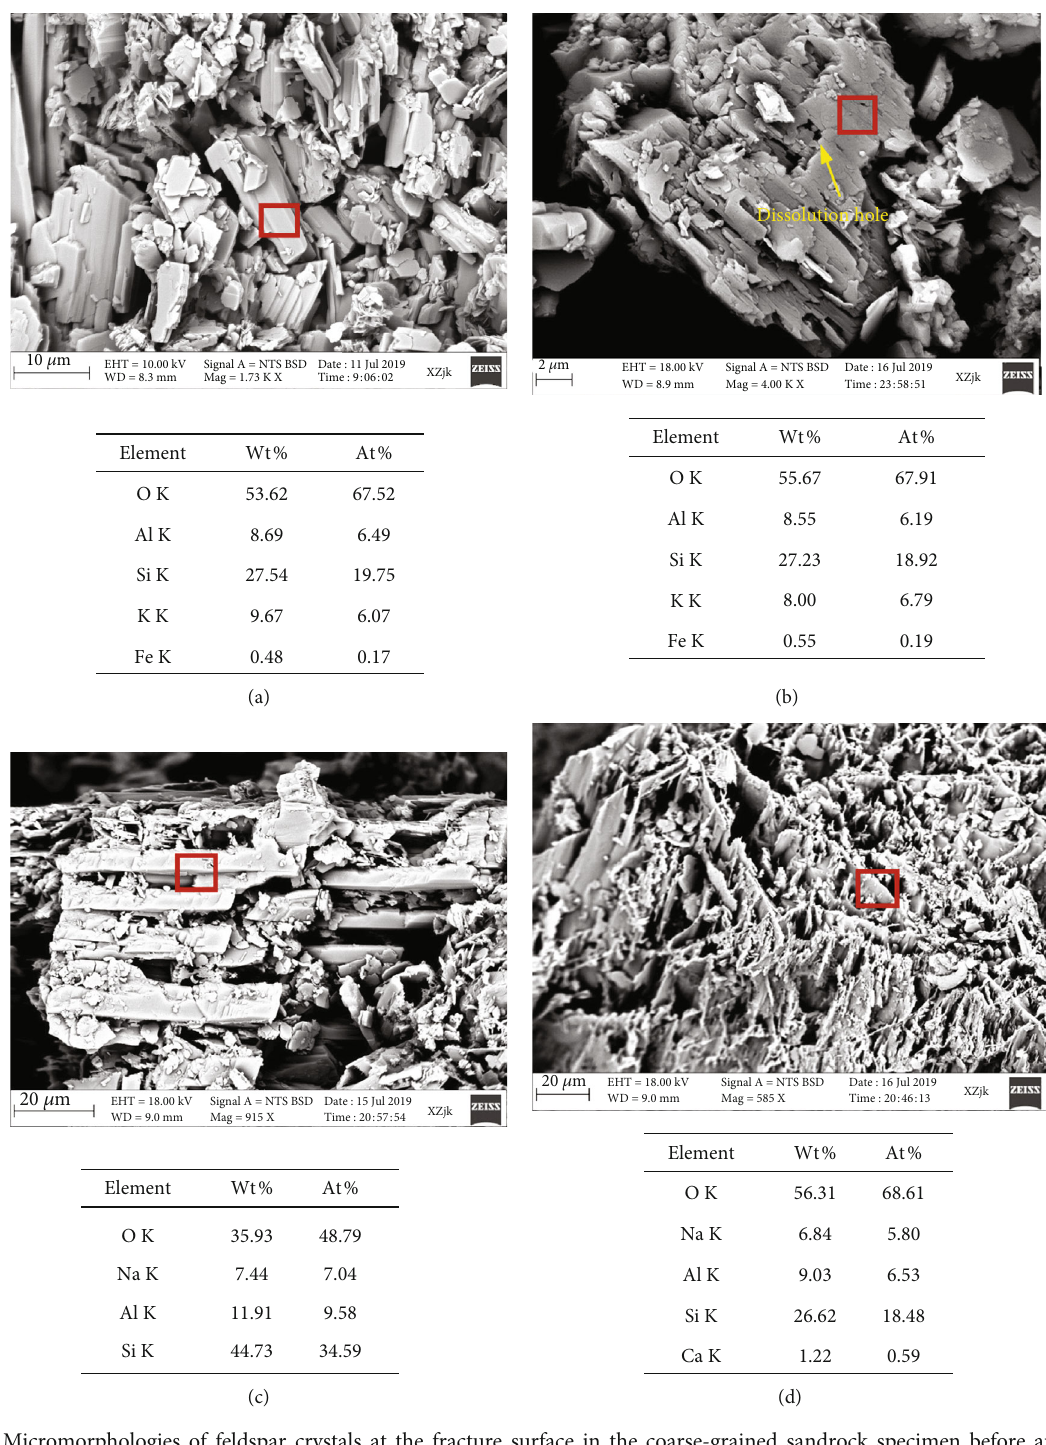
Figure 5: Micromorphologies of feldspar crystals at the fracture surface in the coarse-grained sandrock specimen before and after the experiment. (a) Potassium feldspar crystals (before the experiment). (b) Corroded potassium feldspar crystals (after the experiment). (c) Albite crystals (before the experiment). (d) Corroded albite crystals (after the experiment). Note: to con fi rm the mineral composition in the areas marked by the rectangles, an energy dispersion spectrum (EDS) analysis was performed, and the results are presented in the tables below the SEM images (the same below). In the tables, Wt% means weight percentage, At% means Atomic percentage, and the same